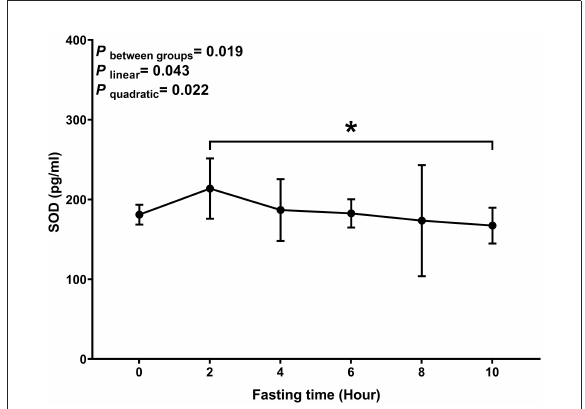
FIGURE2 Postprandial changes in plasma MDA. Data are presented as the means, with the error bars representing the 95% confidence intervals of the means. **Indicates a statistically significant difference of MDA at the 10th hour as compared with the other time points at alpha = 0.01; all statistically significant differences are displayed.